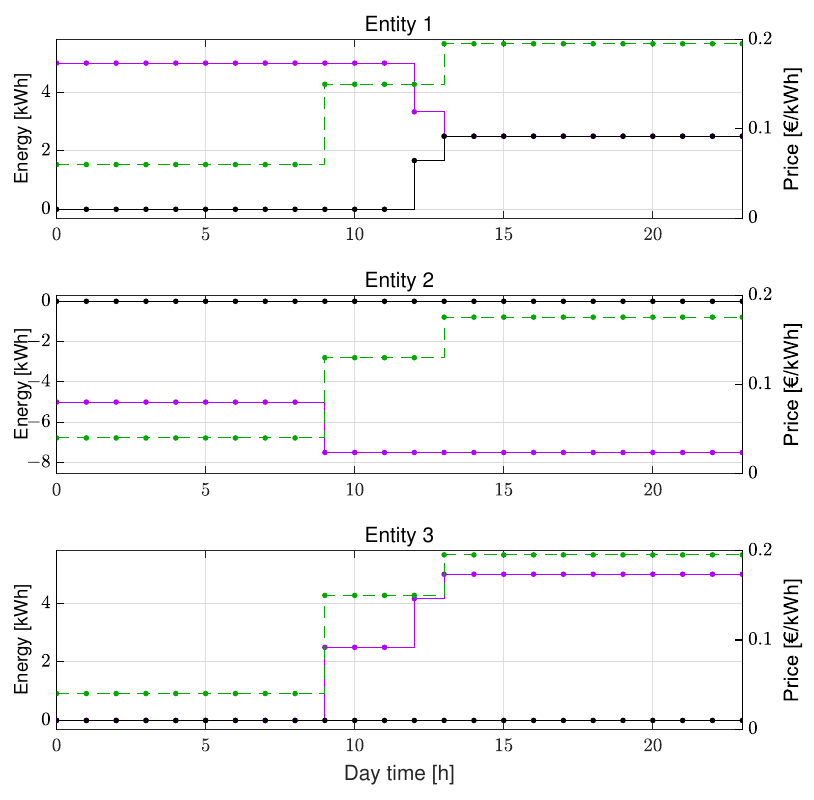
Figure 4. Example 1. Energy exchanged inside the community (purple), energy exchanged with the grid (black) and community prices (green) for entities 1, 2 and 3.